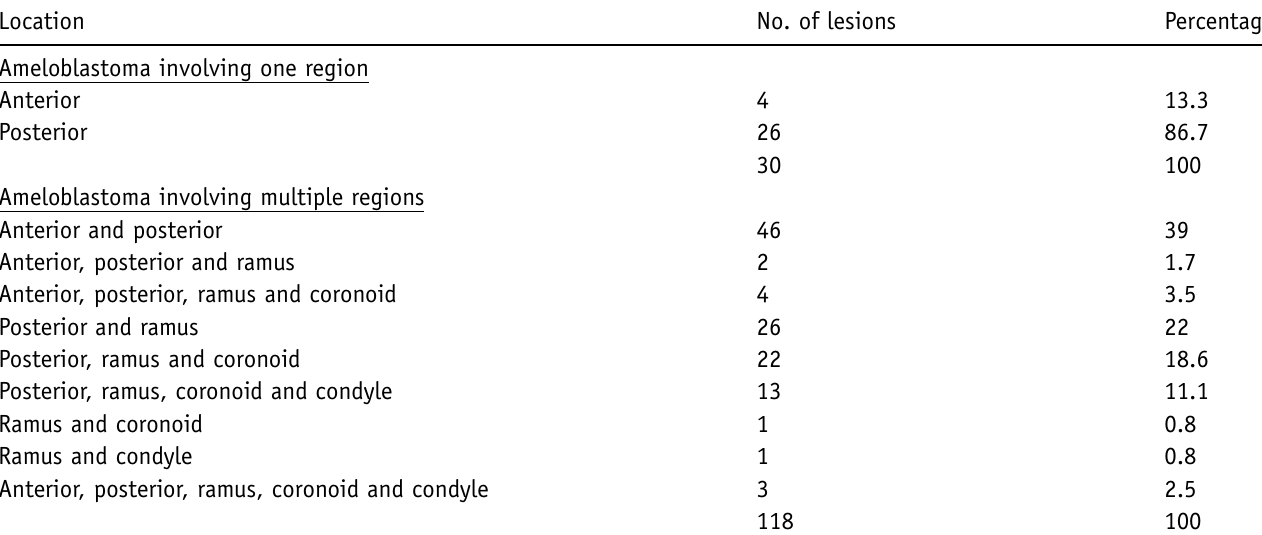
Table II. Distribution of ameloblastoma in the mandible.